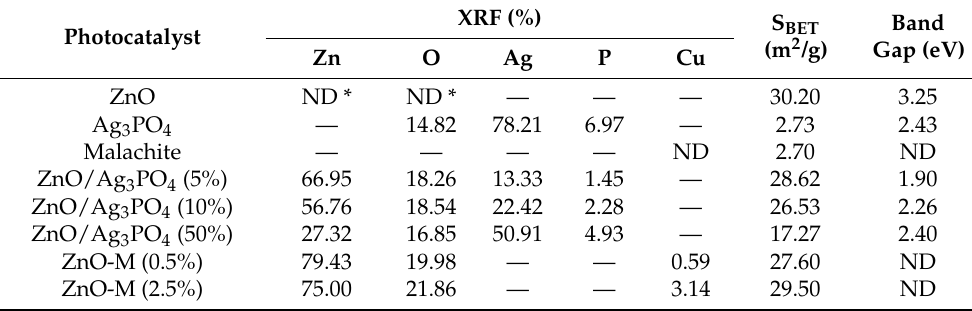
Table 1. Summary of characterization results.